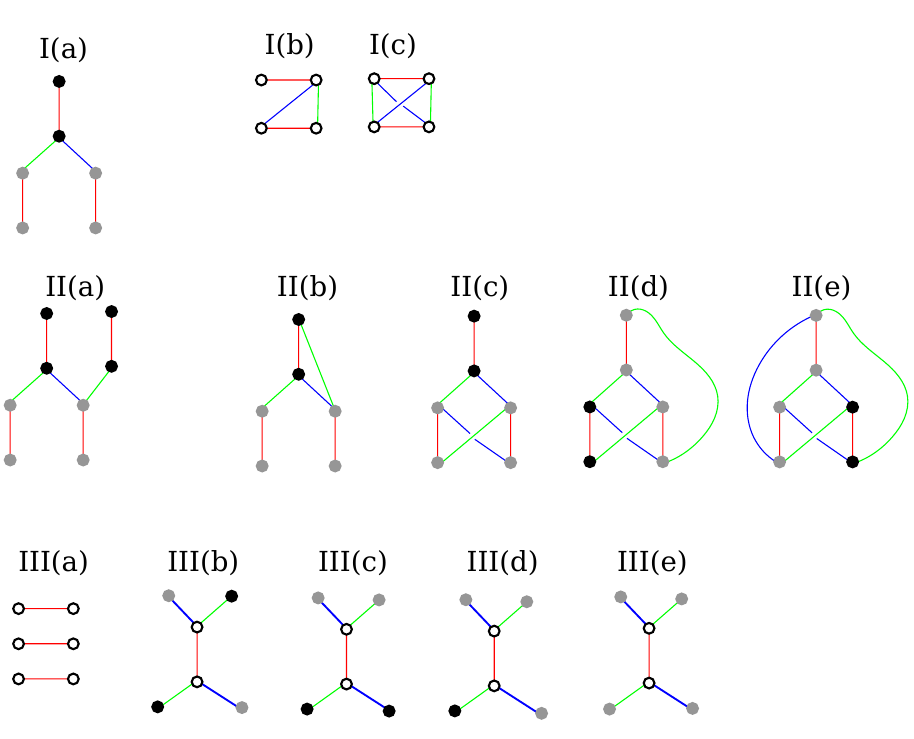
Figure 5: Three stages in constructing the proper